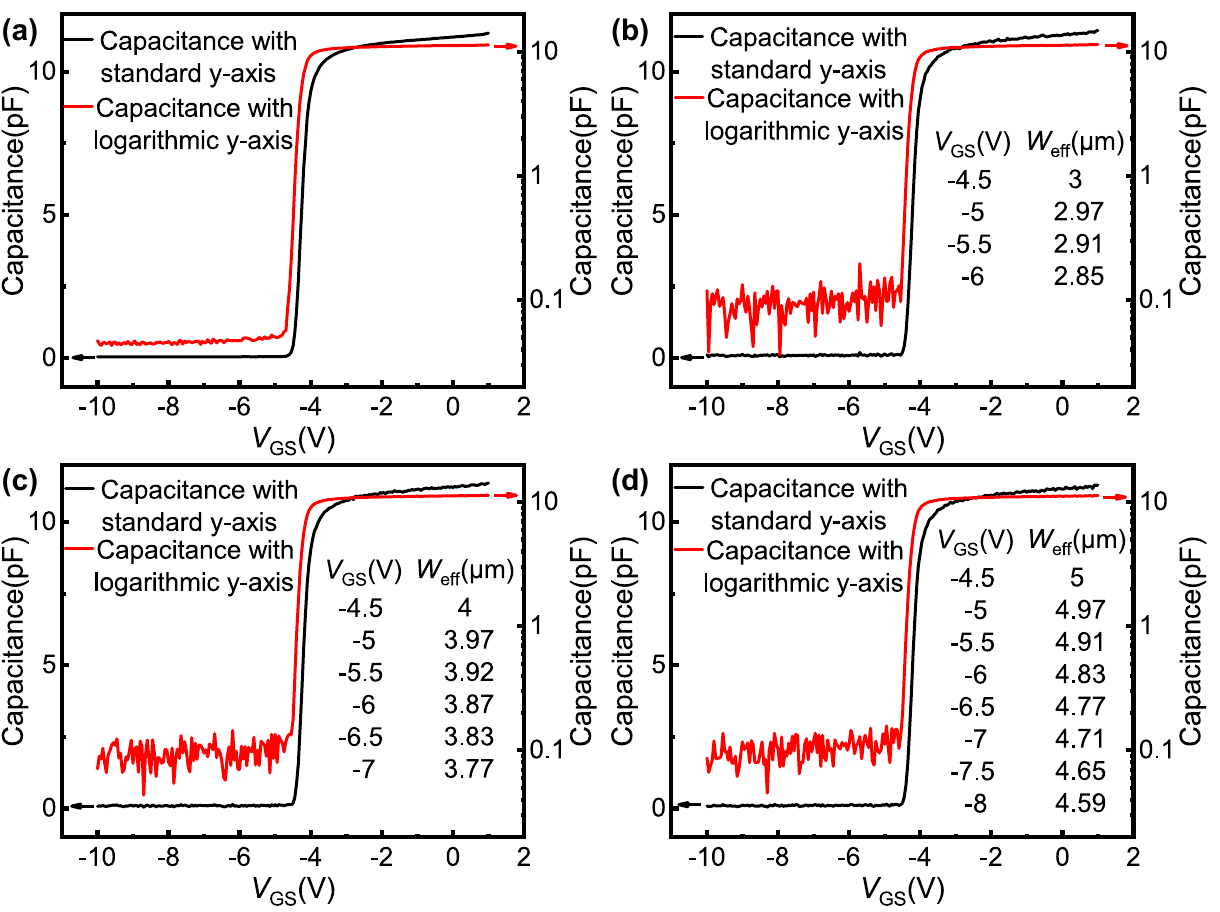
Figure 3. The measured C–V characteristics with standard y-axis and logarithmic y-axis: ( a ) sample 1, ( b ) sample 2, ( c ) sample 3, and ( d ) sample 4. When measuring C–V characteristics, different potentials are applied to gate and source respectively, and source and drain are not shorted. For open-gate devices, the capacitances of the two gates are measured separately and summed to obtain the capacitance shown in the figure. The effective widths of the open region under different gate bias calculated according to the C–V characteristics are also marked in the